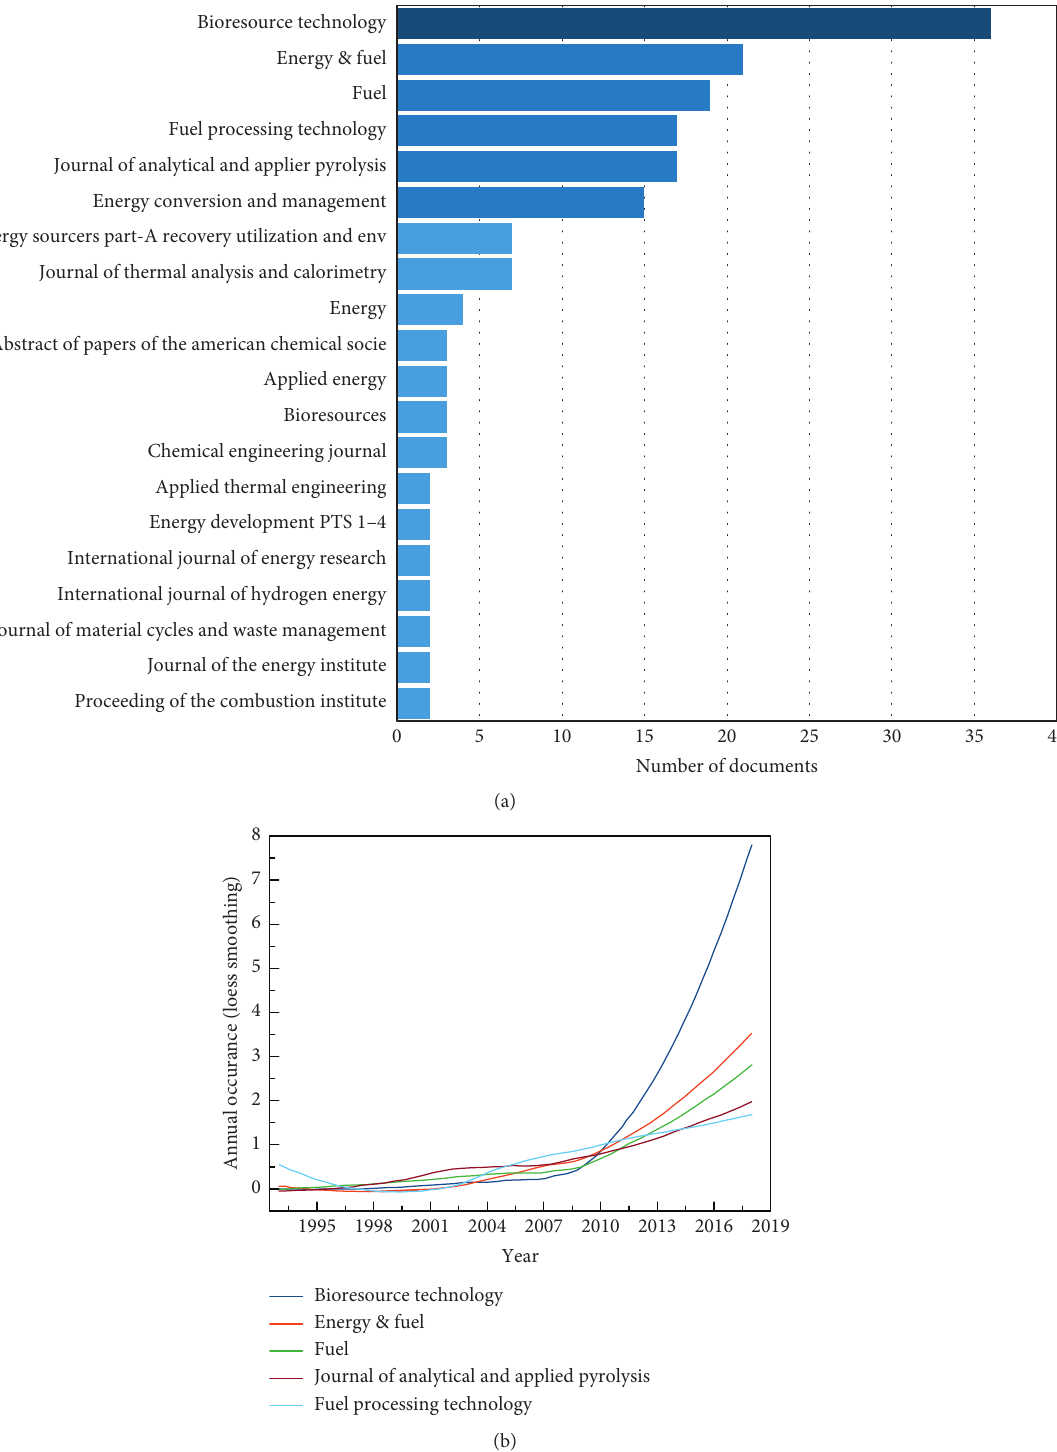
Figure 4: (a) Most relevant sources and (b) source growth